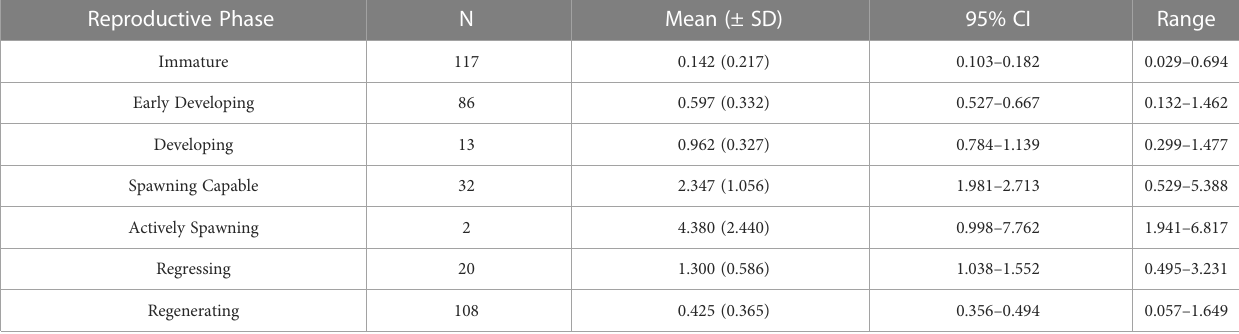
TABLE 2 The mean (± SD) Gonadosomatic Index (GSI) for each reproductive phase of female Etelis coruscans from the main Hawaiian Islands. Reproductive Phase N Mean (± SD) 95% CI Range